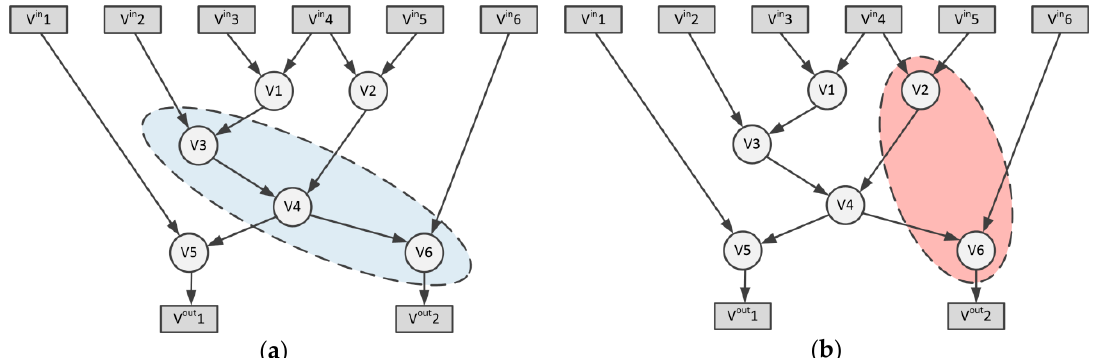
Figure 3. Vertices selection for new instruction template: ( a ) Convex graph selection for new instruction template; ( b ) Non-convex instruction template selection .